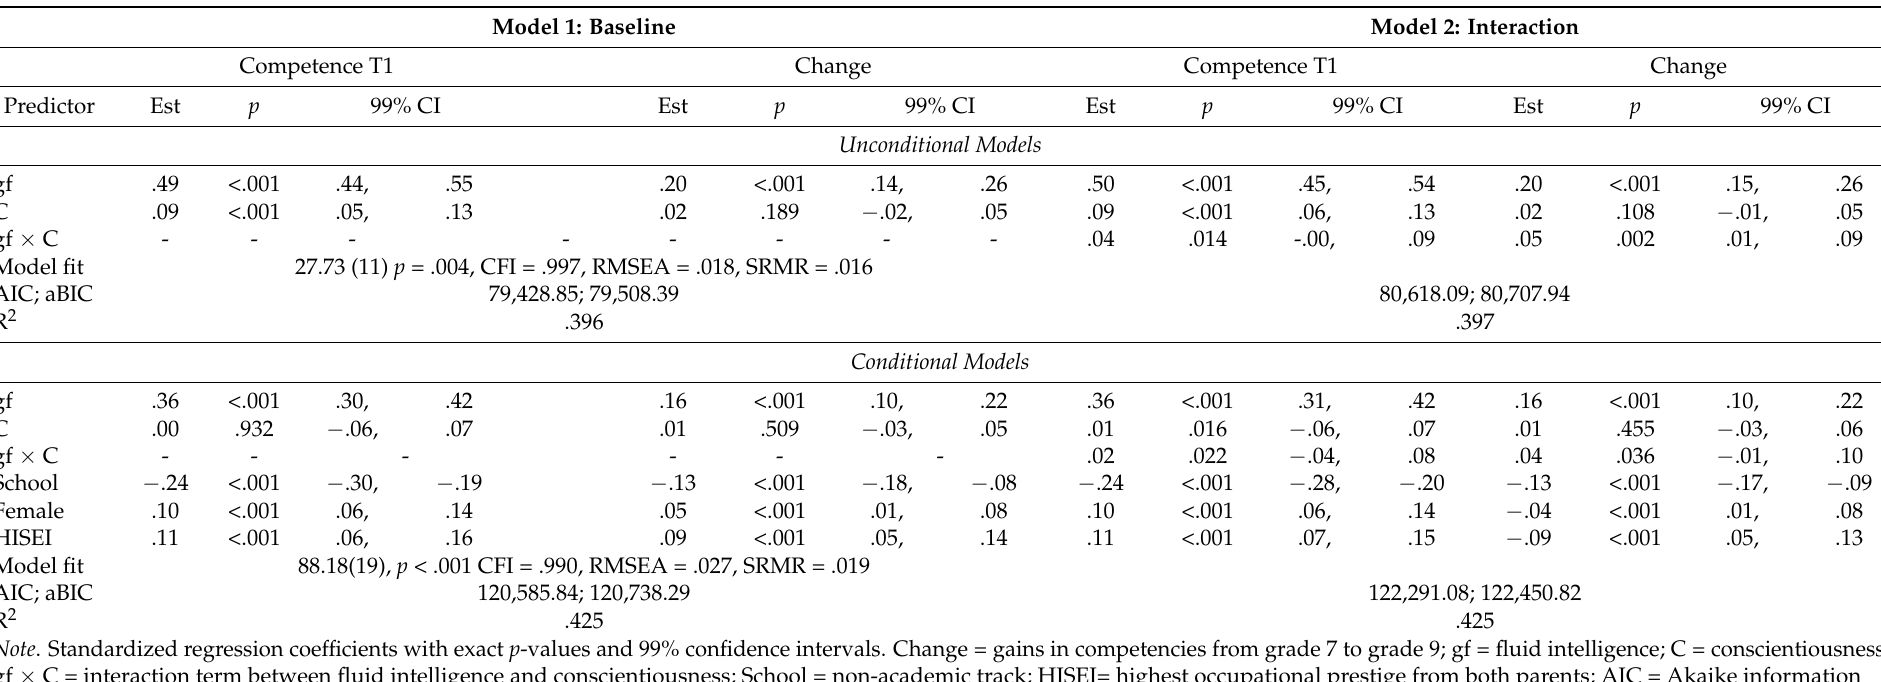
Table 4. Latent change score models predicting reading competence baseline levels and gains in SC3.